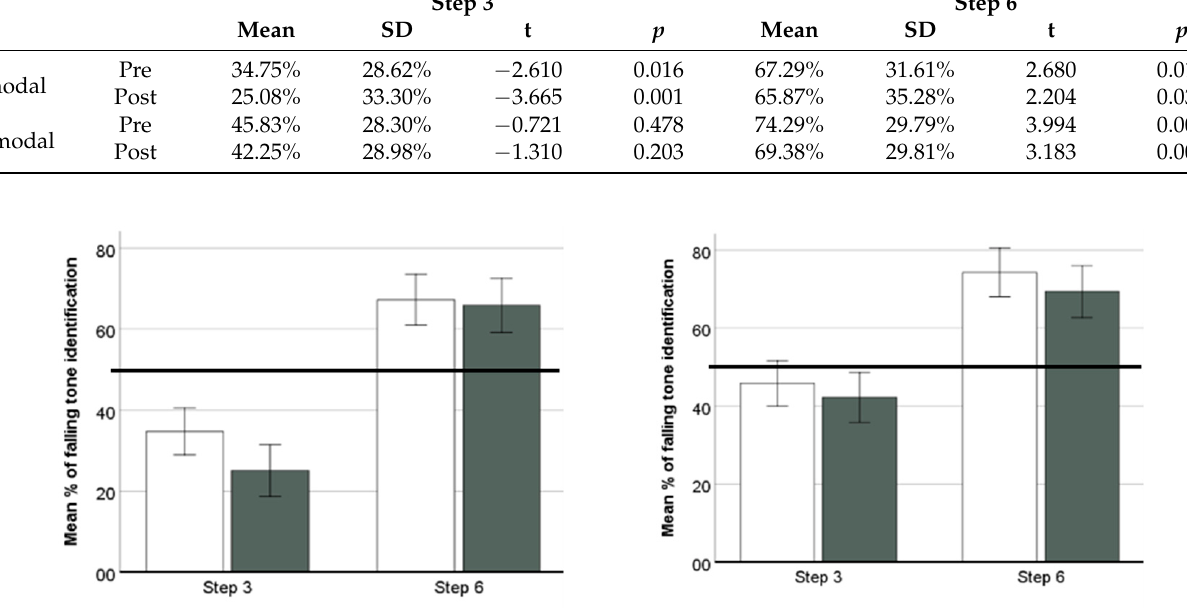
Figure 4. Mean percentage of “falling” classifications for steps 3 and 6 before and after bimodal ( left ) and unimodal ( right ) distributional learning (Error bars = ± 1 standard error) White bars indicate performance at pretest, and black bars posttest. The horizontal line indicates chance (50%) performance.